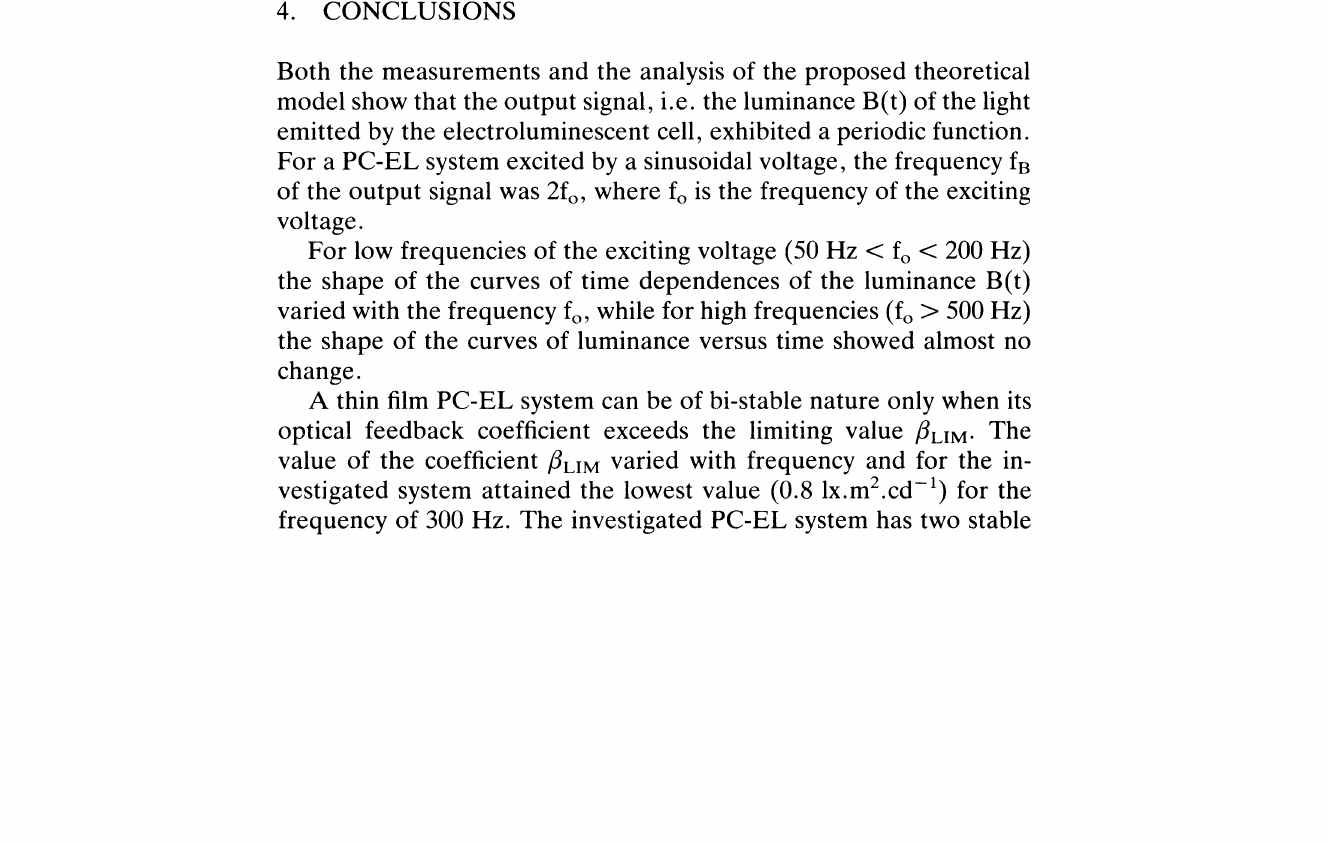
FIGURE 8 Dependence of the limiting value of illumination intensity on the